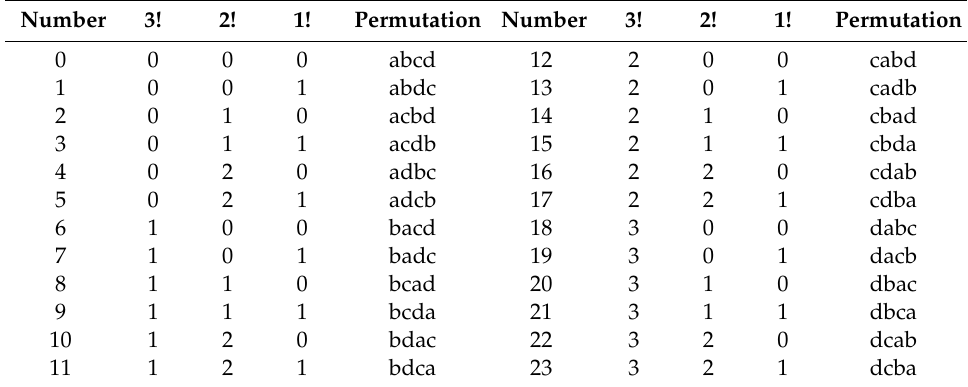
Table 1. Illustration of the factorial basis decomposition of the 24 possible permutations of the group of four elements